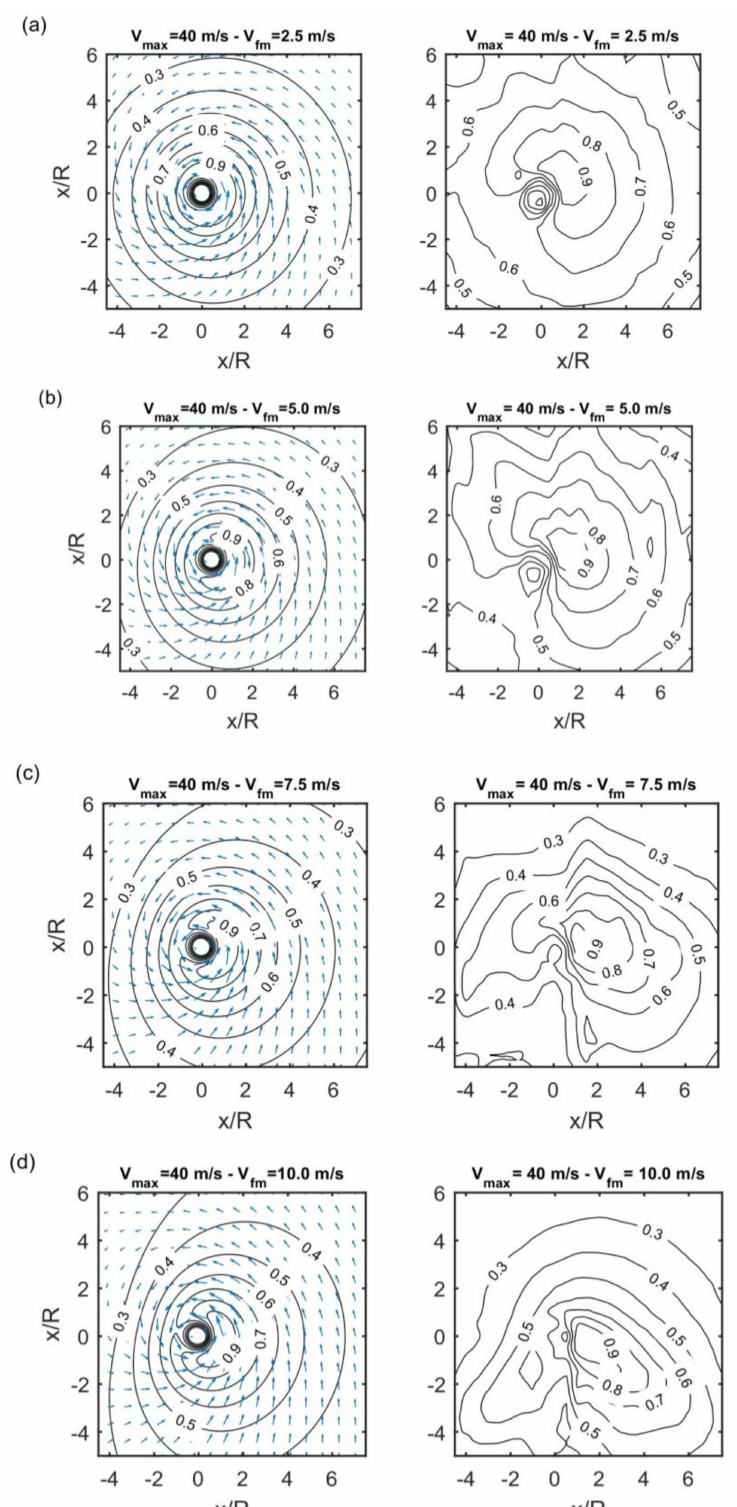
Figure 5. Tropical cyclone wind fields (left) and wave fields (right). The wind is calculated from the Holland vortex [1] and the waves from the results of Young [43]. The contours show normalized wind speed U 10 / V max (left) and normalized wave height H s / H max s (right). Each of the panels ( a – d ) are for a different combination of V fm and V max , as